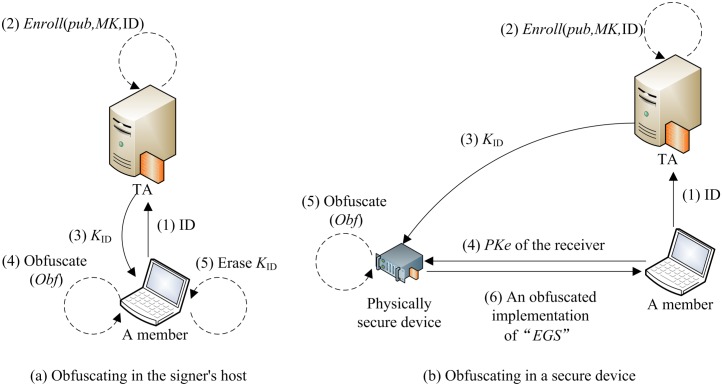
The workflow of obfuscation.